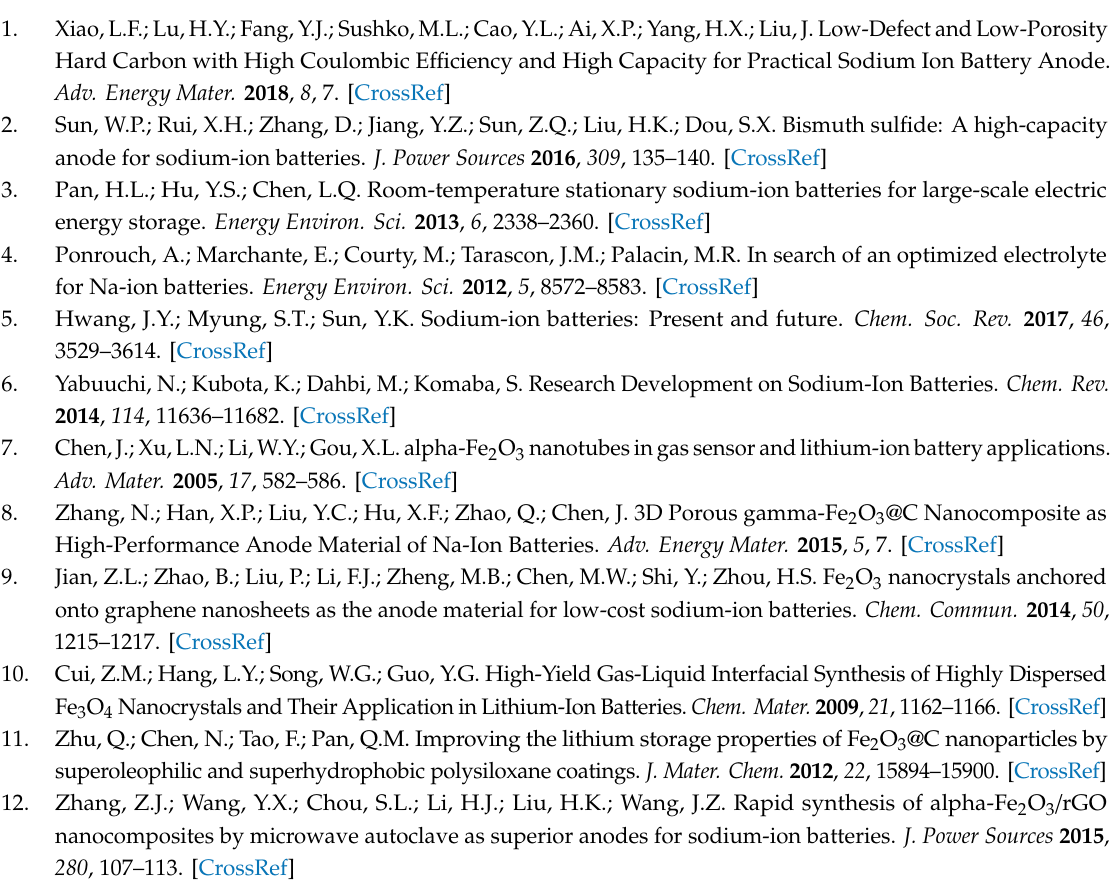
Figure S1: (a) the equivalent electrical circuit (b,c) The Z ’- ω − 1 / 2 plots for the Fe 2 O 3 / NG and Fe 2 O 3 / Fe 3 O 4 / NG. Table S1. Calculation of capacity contributed by Fe 2 O 3 in the Fe 2 O 3 / Fe 3 O 4 / NG